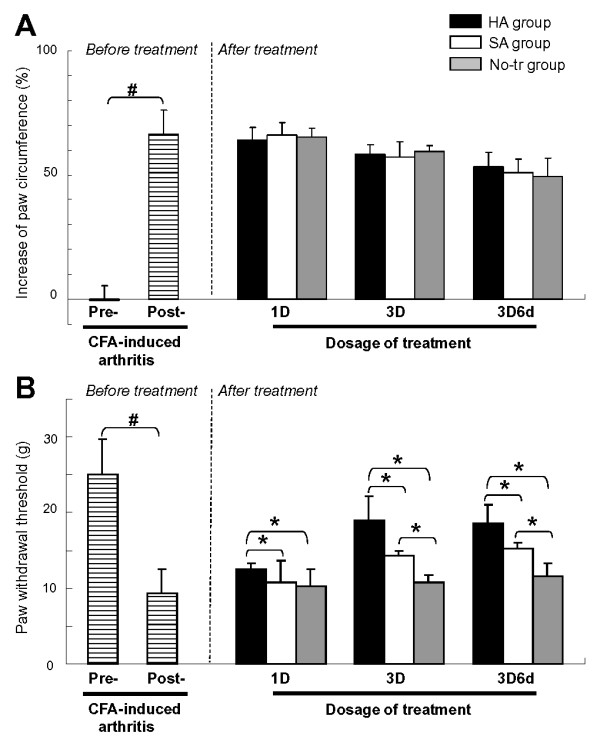
Results of edema (a) and pain behavioral (b) assessments. Data were calculated before treatment at the conditions of pre-complete Freund's adjuvant (CFA)-induced and post-CFA-induced arthritis and after treatment at conditions of one dose (1D), three doses (3D), and follow-up at the 6th day after three doses (3D6d) in hyaluronan (HA), saline (SA), and 'no treatment' (No-tr) groups. Each bar represents the mean ± standard deviation in body weight and mean ± standard error of the mean in paw circumference and withdrawal threshold. #P <0.05, Student t test for comparison of pre- and post-arthritic conditions before treatment. *P <0.05, Bonferroni post hoc test for comparison of difference between groups at dosages of 1D, 3D, and 3D6d after treatment.